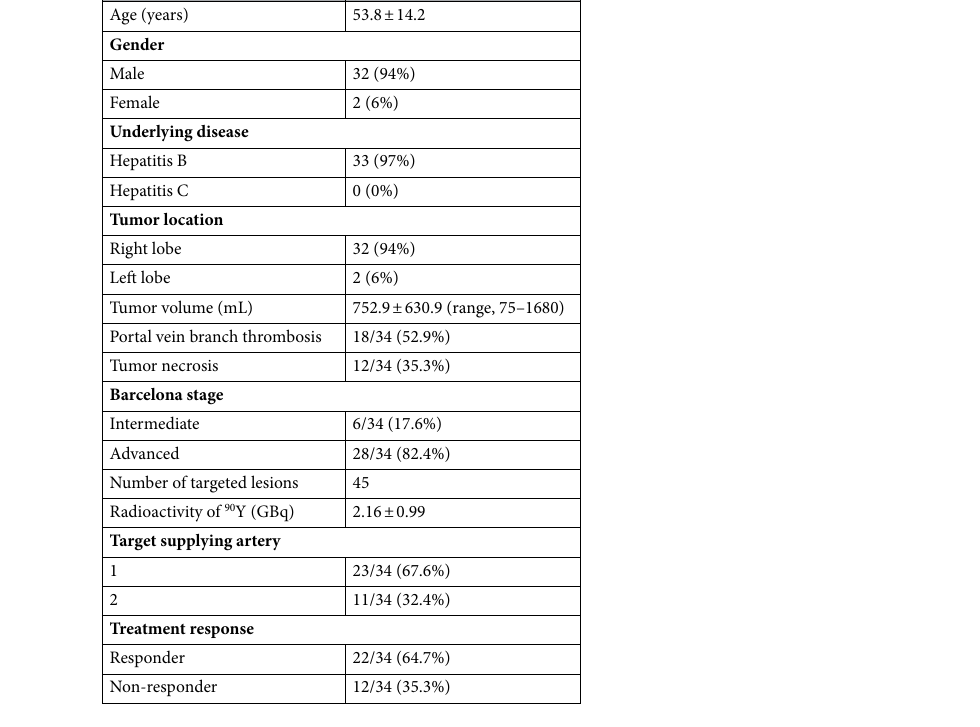
Table 1. General characteristic of